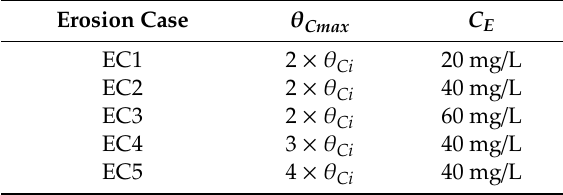
Table 4. Summary of di ff erence in sediment consolidation magnitude, θ Cmax, and inlet suspended sediment concentration, C E , for the di ff erent erosion cases. θ Ci refers to the final critical Shields parameter calculated using Equation (13) for a sediment fraction